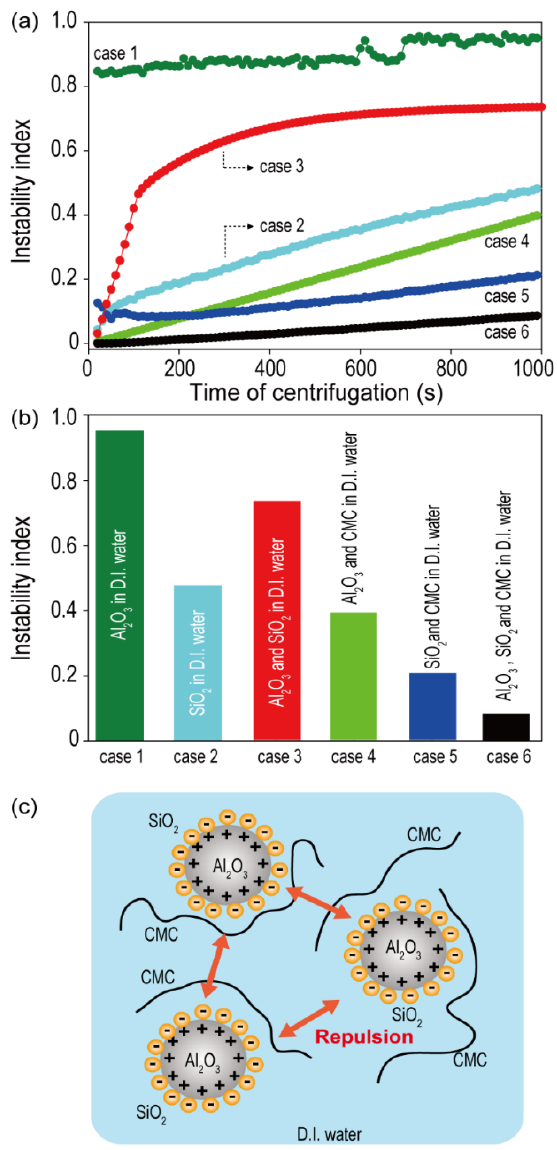
Figure 1. Instability indices for various types of aqueous ceramic coating slurries determined using Lumisizer ( a ) as a function of centrifugation time and ( b ) at a centrifugation time of 1000 s. ( c ) A schematic demonstrating the formation of the SiO 2 sheath around the Al 2 O 3 particles, resulting in the stable dispersion of the dual ceramic slurry.